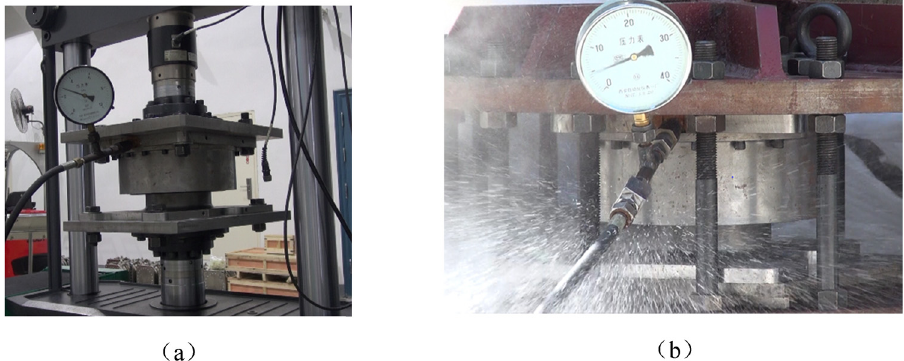
Figure 12: Installation diagram of the air spring mechanical characteristics test: ( a ) sti ff ness test and ( b ) burst pressure test.